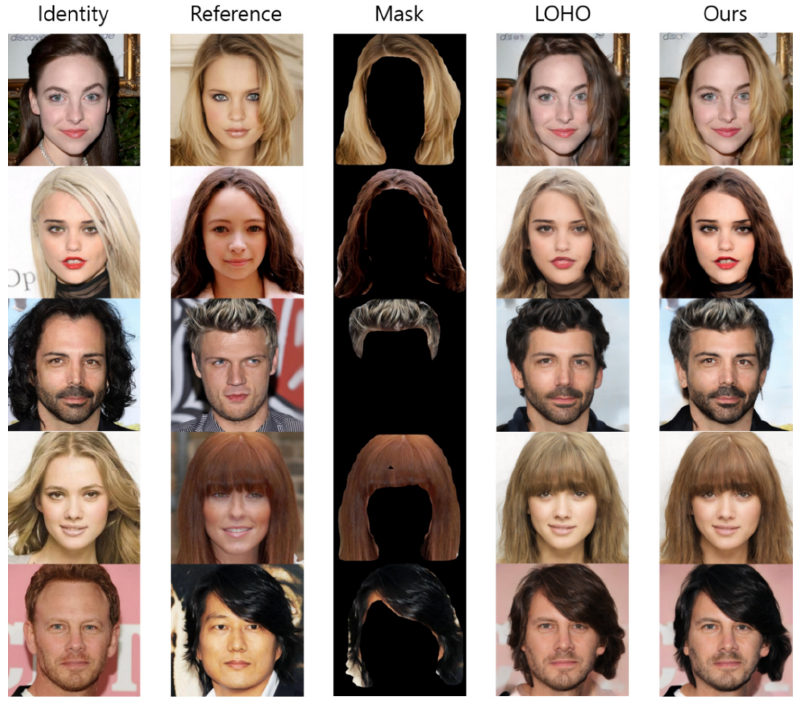
Figure 11. Comparison of LOHO and our model. Compared to the other models, our results were quite similar to the referenced image of hair color, and the images were synthesized more naturally.